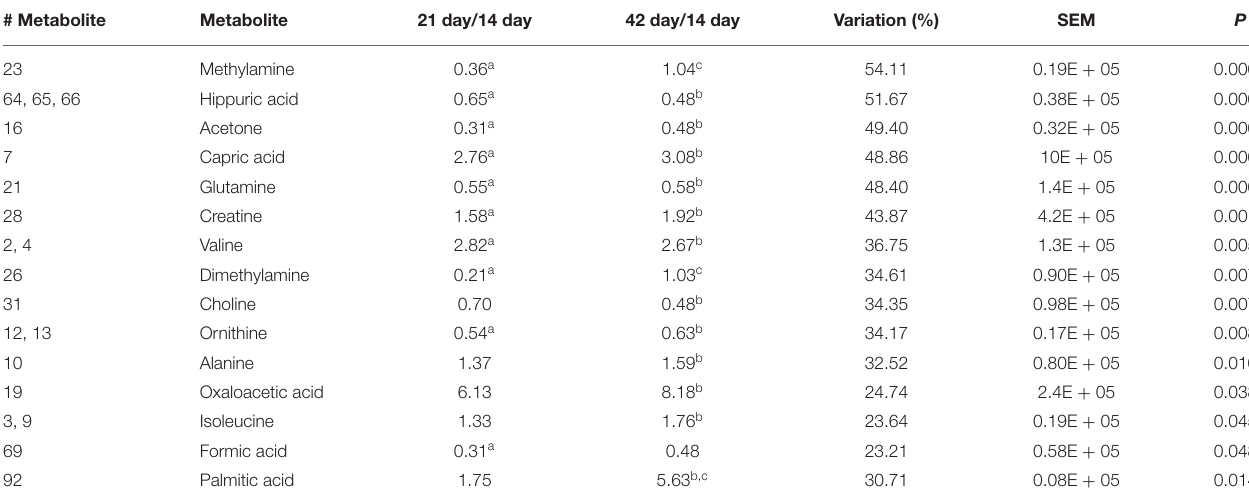
TABLE 3 | Effect of collection date (14, 21, and 42 days) on milk metabolites from